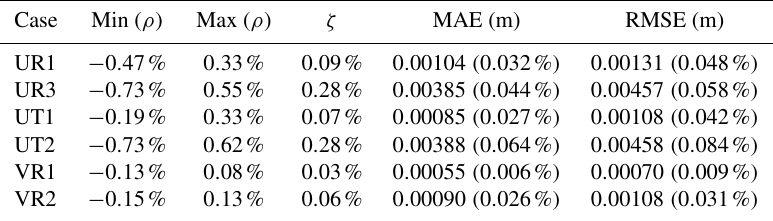
Table 4. Difference measures using Eqs. (23)–(28) for analytical test cases of MacDonald et al. (1995). Nondimensional MAE and RMSE are shown in parentheses.